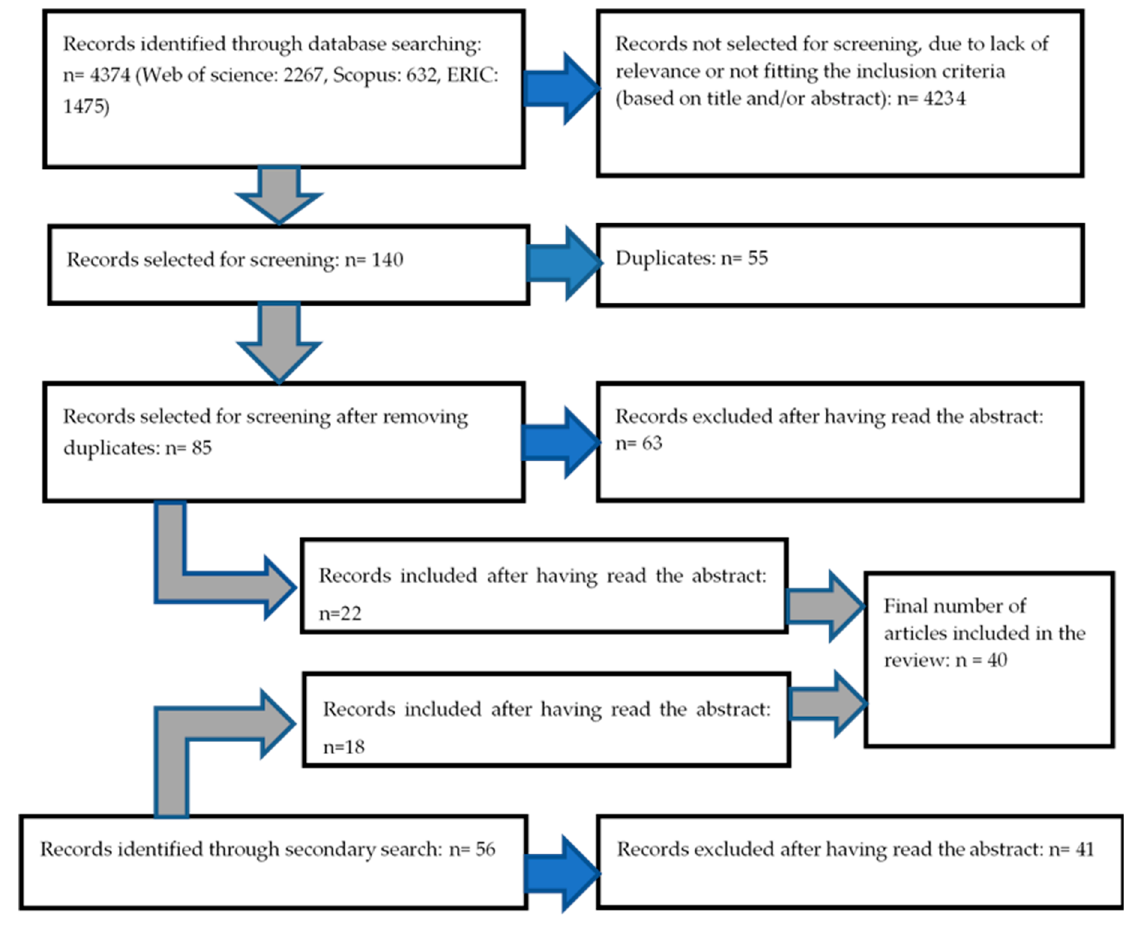
Figure 1. Prisma Flow Diagram.